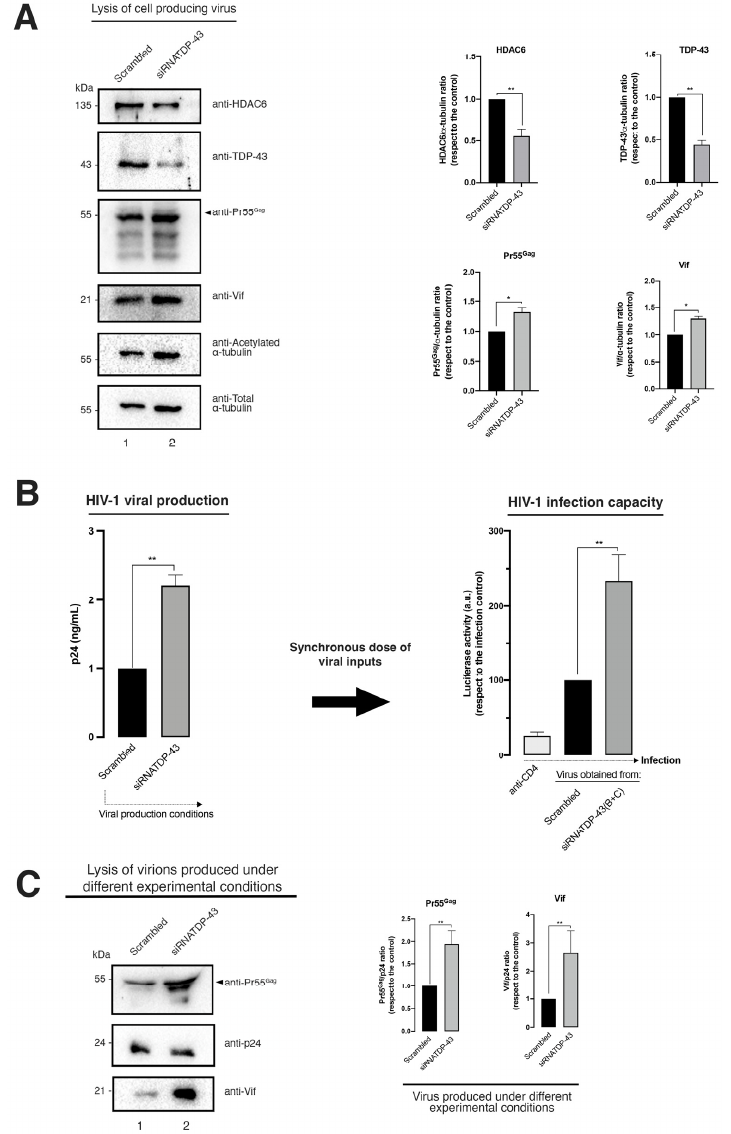
Figure 7. The specific silencing of TDP-43 in virus-producing cells decreases the protein level of HDAC6, stabilizing acetylated α -tubulin and HIV-1 Pr55 Gag and Vif viral proteins, thereby enhancing the production of viral particles and their infectivity. ( A ) The biochemical western blot analysis of TDP-43, HDAC6, acetylated α -tubulin, HIV-1 Pr55 Gag , and Vif proteins in virus-producing HEK-293T cells treated with a pull of siRNA oligonucleotides specific against TDP-43 (siRNATDP-43) or in the control (scrambled-treated cells). Total α -tubulin for protein load control is shown under each experimental condition. Data are represented as the mean ± S.E.M. of three independent experiments (see replicate data in Figure S7A, Supplementary Materials section). Right : Histograms show the quantification of western blot bands for the TDP-43/, HDAC6/, Pr55 Gag /, and Vif/ α -tubulin ratios under this experimental condition. Data associated with the quantification of replicates are shown in Figure S7A, Supplementary Materials section. ( B ) Left : ELISA-HIV-1 p24 protein quantification of produced viral particles and siRNA-TDP-43- or scrambled-treated virus-producing HEK-293T cells. The ELISA-p24 technique was standardized with respect to the viral production control, which corresponded to the experimental condition of the scrambled-treated cells. Data are mean ± S.E.M. of three independent experiments. Right : HIV-1 infection was then carried out with synchronous doses of luciferase-pseudoviruses produced under the experimental conditions of panels ( A , B ) in the permissive CEM.NKR-CCR5 CD4+ T cells. CD4-treated cells showed the neutralization of